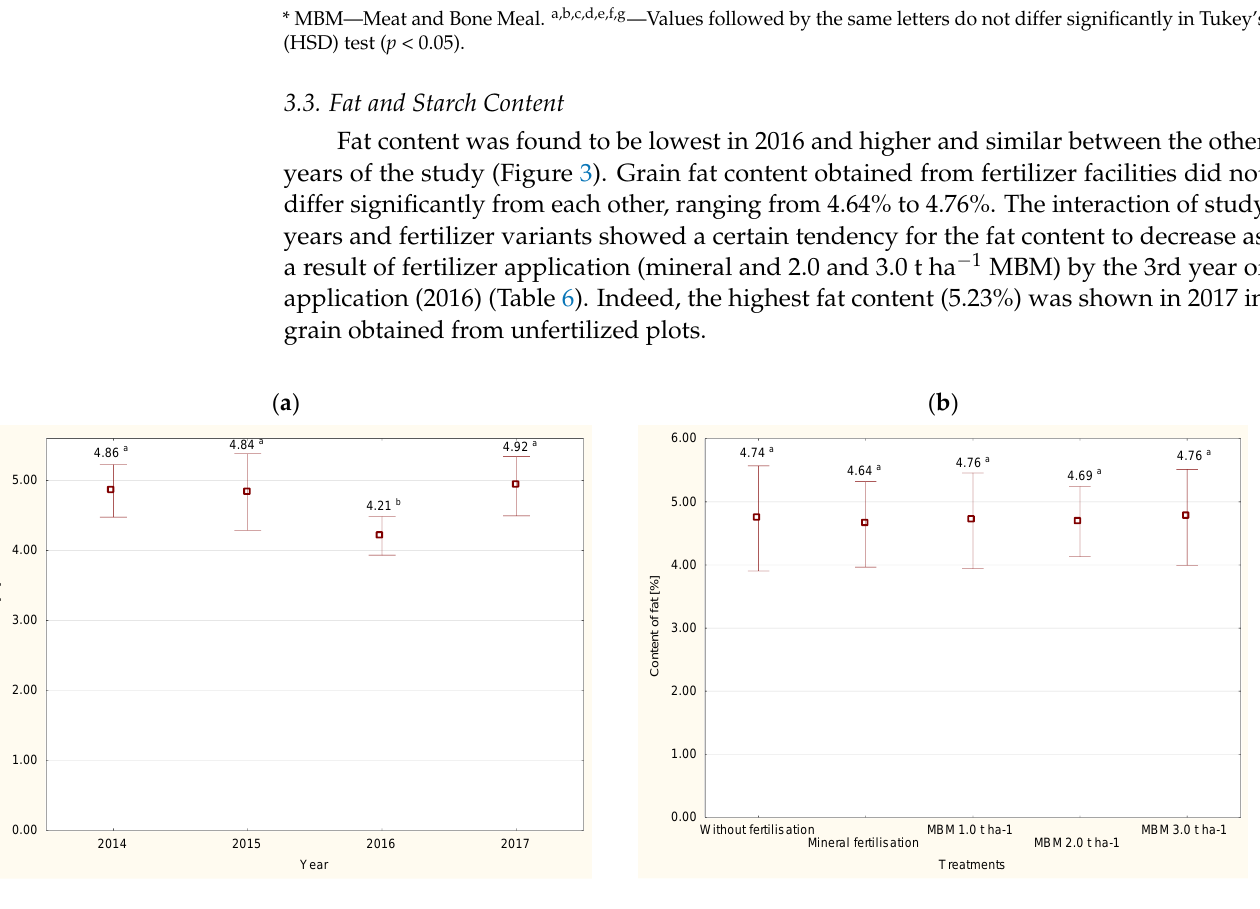
Figure 3. Fat content in corn grains (mean value and standard deviation), ( a ) average for the years, ( b ) average for the treatment. MBM — Meat and Bone Meal. a,b — Values followed by the same letters ( b ) average for the treatment. MBM—Meat and Bone Meal. a,b —Values followed by the same letters do not differ significantly in Tukey’s (HSD) test ( p < 0.05). do not differ significantly in Tukey’s (HSD) test ( p < Table 6. The fat content in corn grains (mean value and standard deviation), interaction between the years and treatments %.